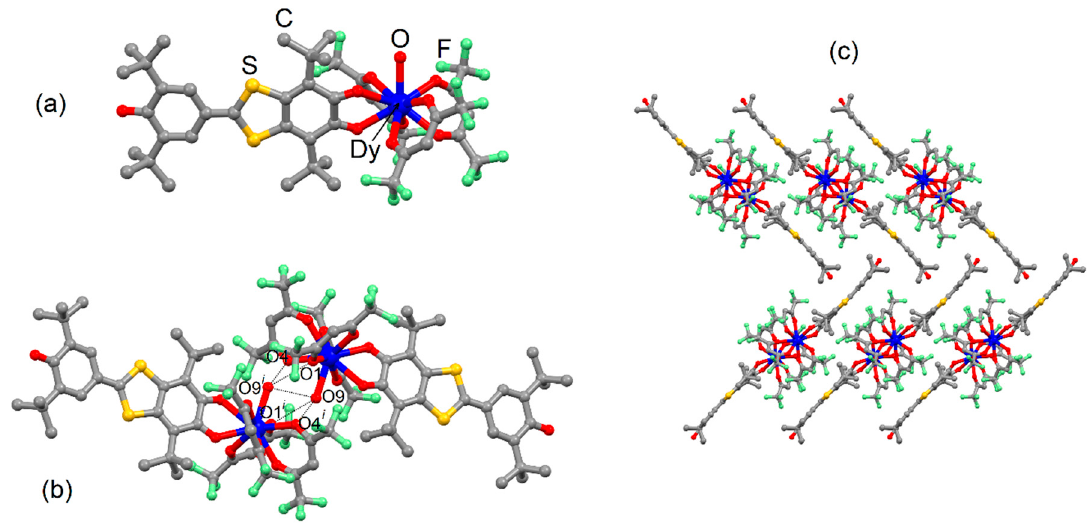
Figure 1. ( a ) Molecular structure, ( b ) formation of the dimer through multiple hydrogen bonds highlighting in dashed lines and ( c ) the crystal packing along the b axis for 1 . Color code: gray: carbon, blue: dysprosium, red: oxygen, green: fluorine and yellow: sulfur.